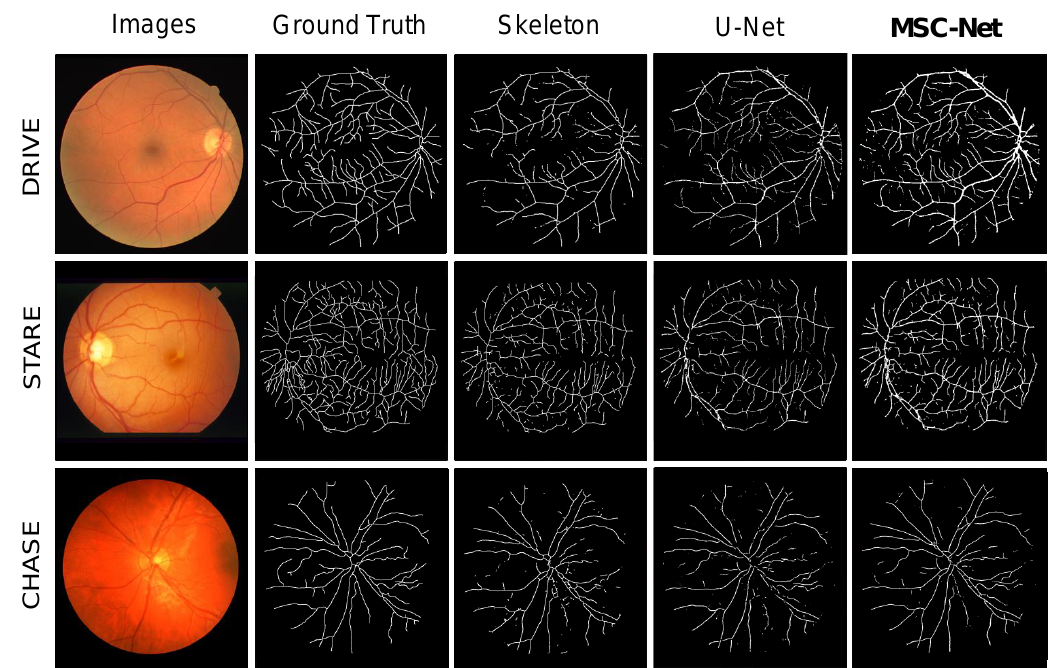
Figure 5. Visualization results of different centerline extraction methods. The centerline extracted by our method will have better